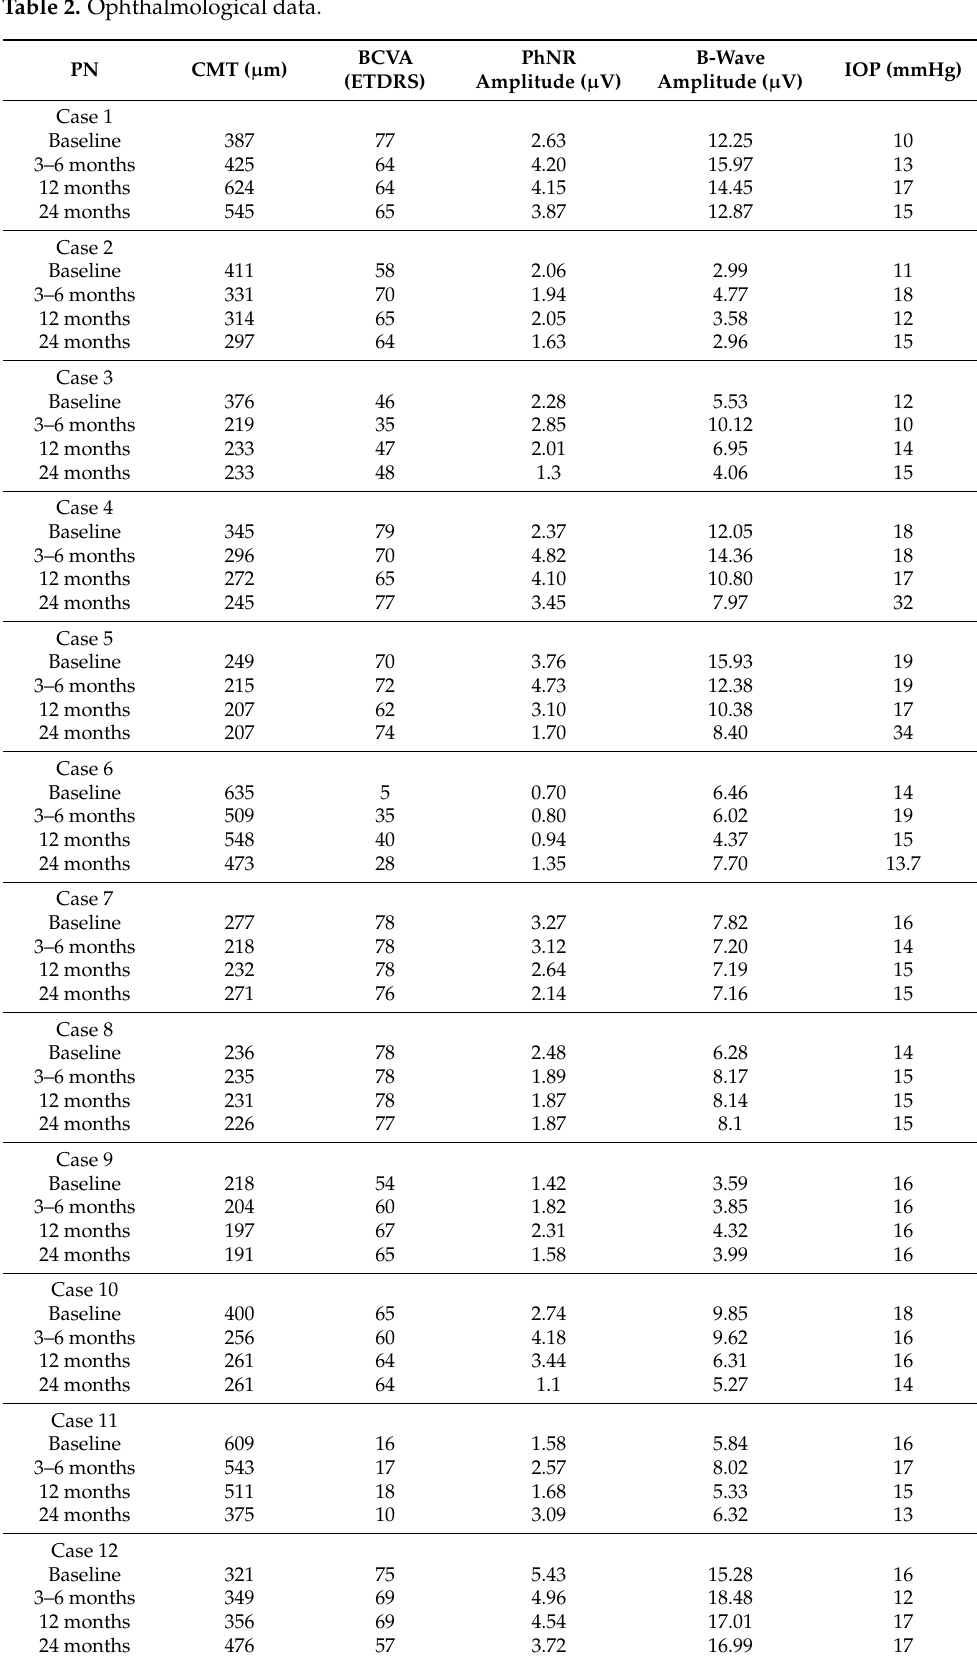
Table 2. Ophthalmological